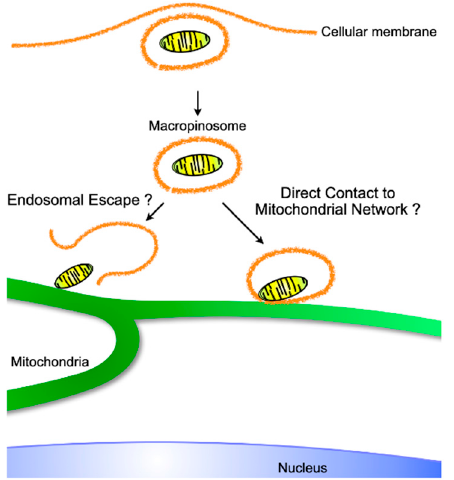
Figure 4. Putative intracellular trajectory of exogeneous internalized mitochondria, which originate from either isolated or exosome ‐ derived mitochondria. Similar to viral endosomal escape, mitochondria might be liberated to make direct contact with the pre ‐ existing mitochondrial network, or, as observed during iron transport, endosomes containing mitochondria might physiologically transport material originating from exogeneous mitochondria.